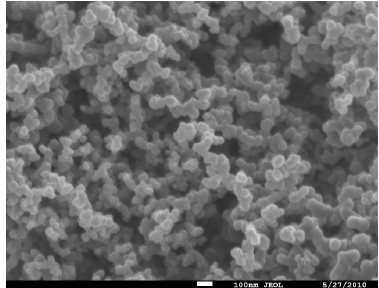
Figure 1. Scanning electron micrographs of sooth obtained from the combustion of kerosene